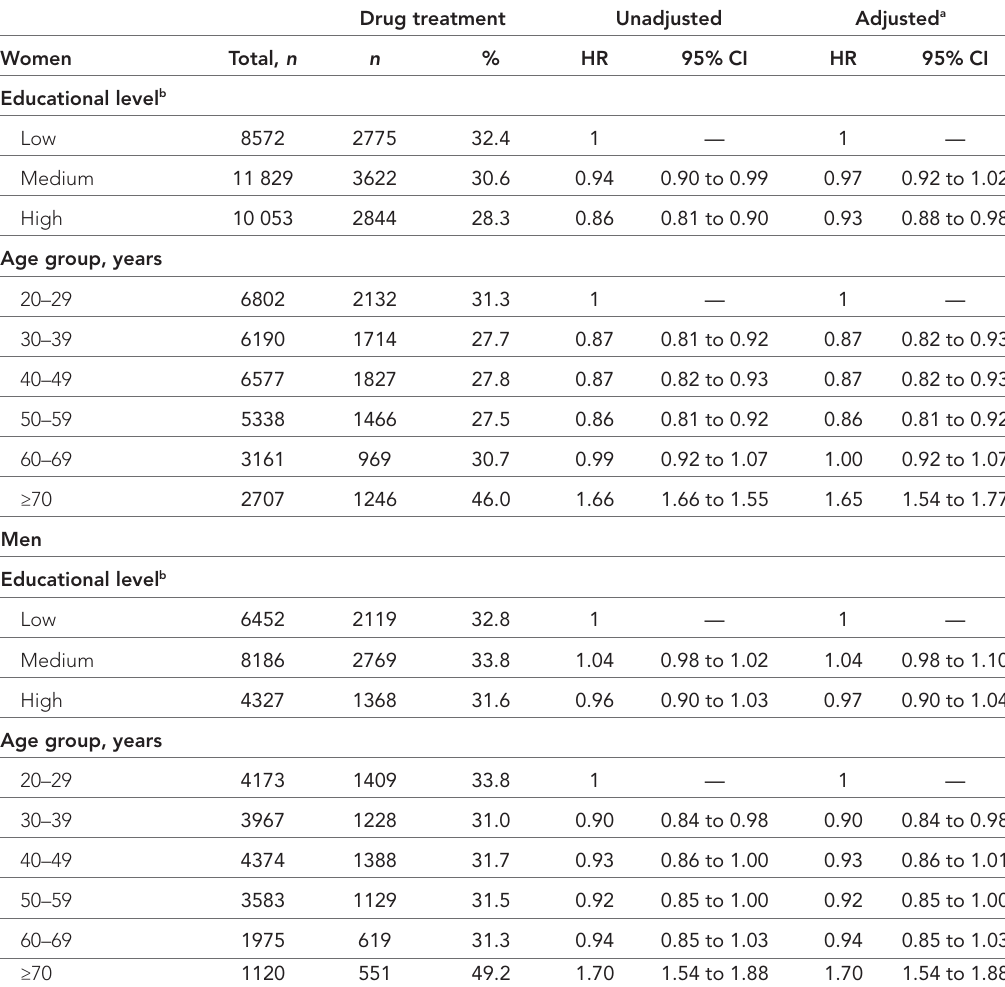
Table 3 Likelihood of receiving drug treatment among patients with a new depression diagnosis in 2015, by education and age; stratified by sex ( N = 49